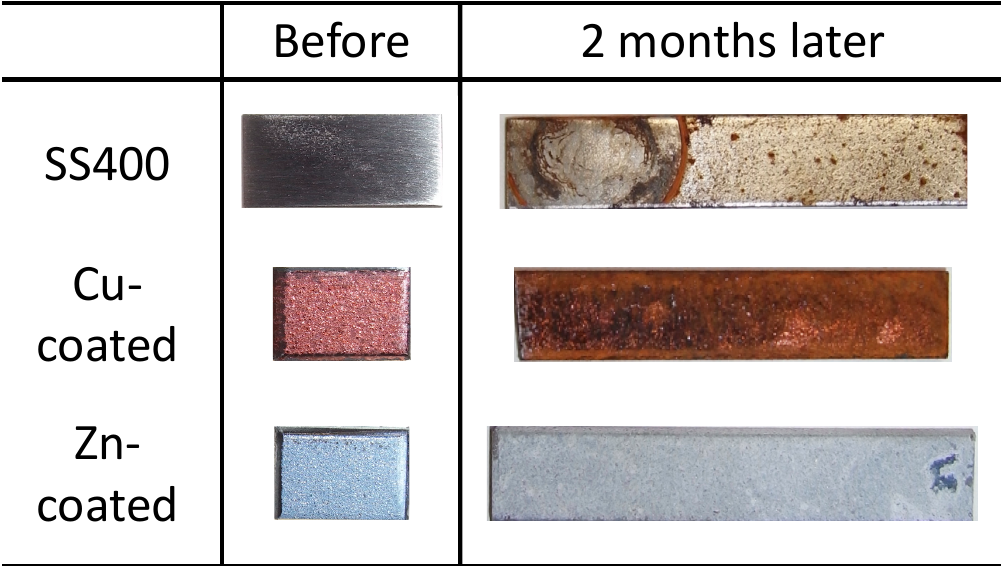
Figure 3. Digital photo images of the outdoor-exposed specimens.